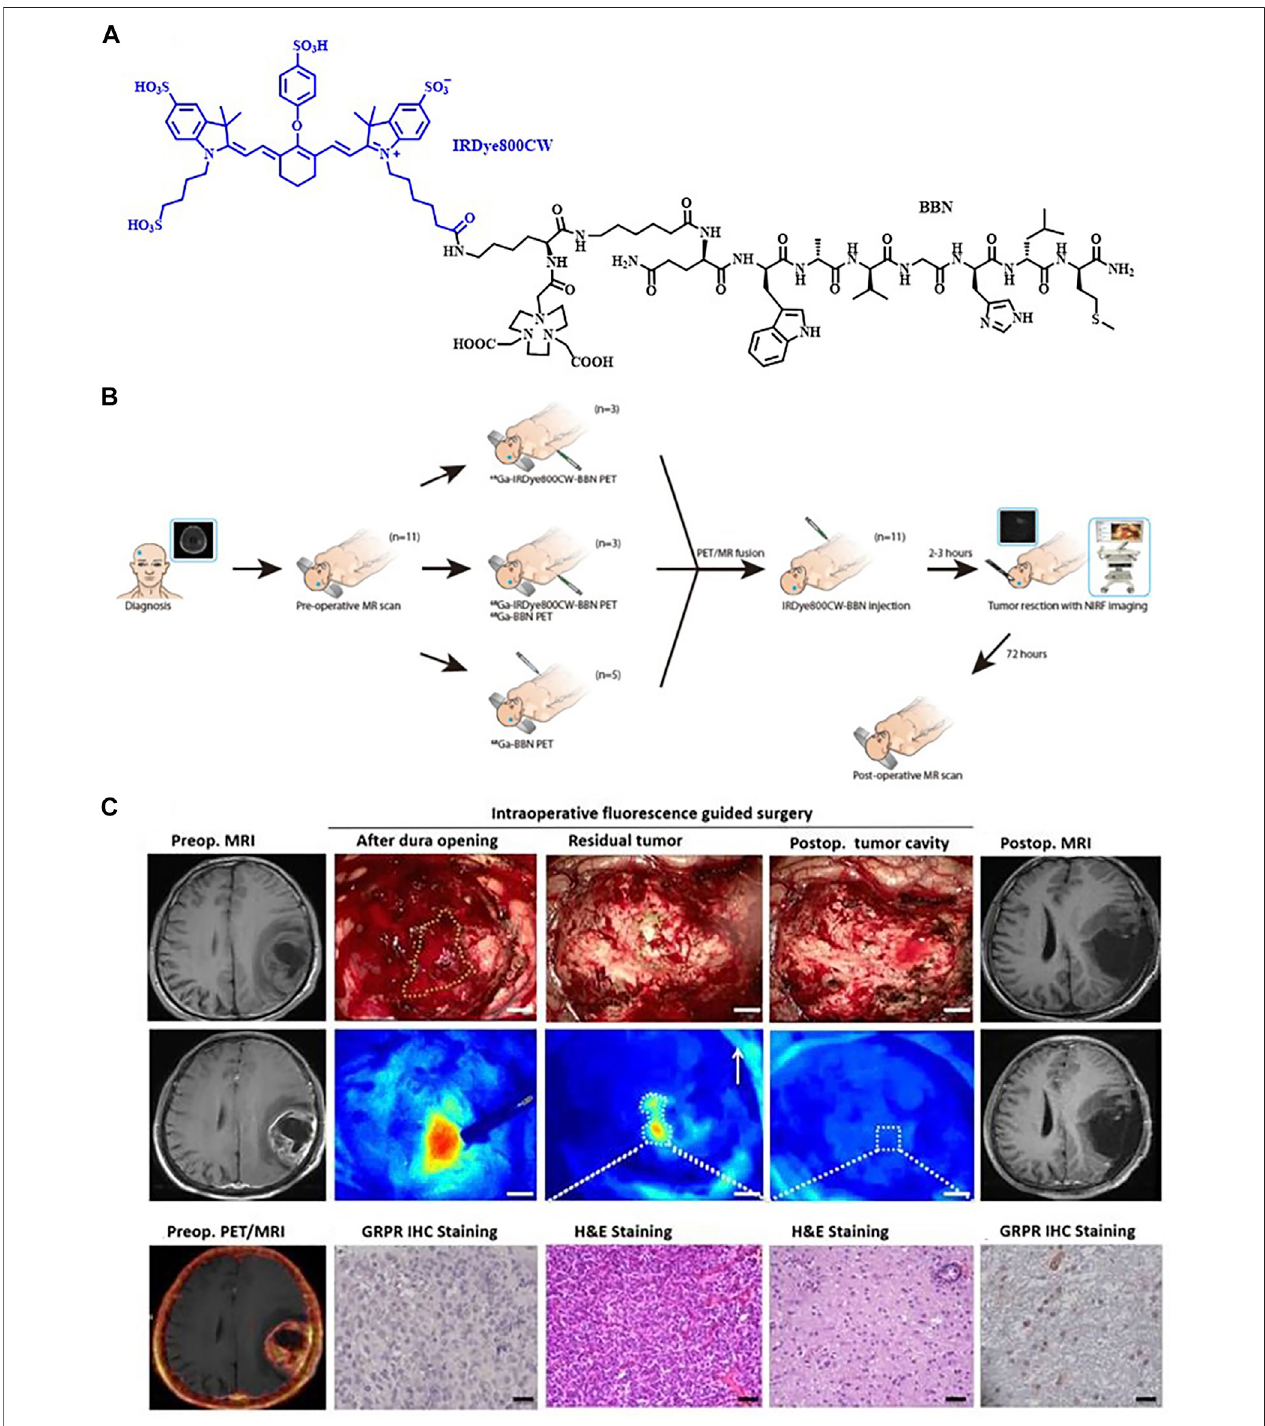
FIGURE 3 | (A) Chemical structure of IRDye800CW-BBN tracer. (B) Scheme of 68 Ga-IRDye800-BBN for the GBM patients. (C) 68 Ga-IRDye800-BBN FI/PET dual-modality imaging guided GBM resection for patient 3. Reproduced with permission from Li et al. (2018). Copyright 2018, Ivyspring International Publisher.